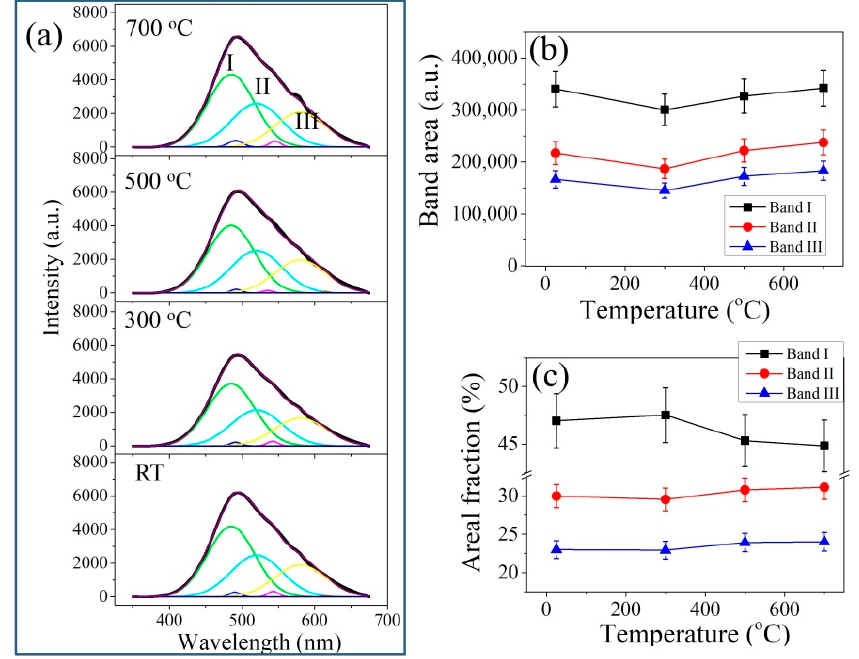
Figure 5. Variations of ( a ) CL spectra, ( b ) band area and ( c ) areal percent of the sub-bands with annealing temperature for the CaSZ samples.